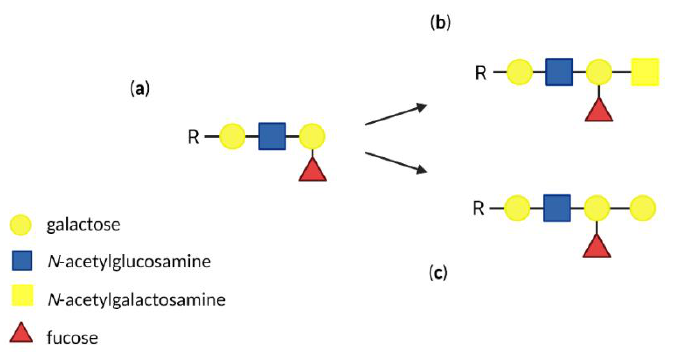
Figure 3. Structures of ABH blood group antigens: ( a ) H antigen, ( b ) A antigen, ( c ) B antigen. Created with BioRender.com.